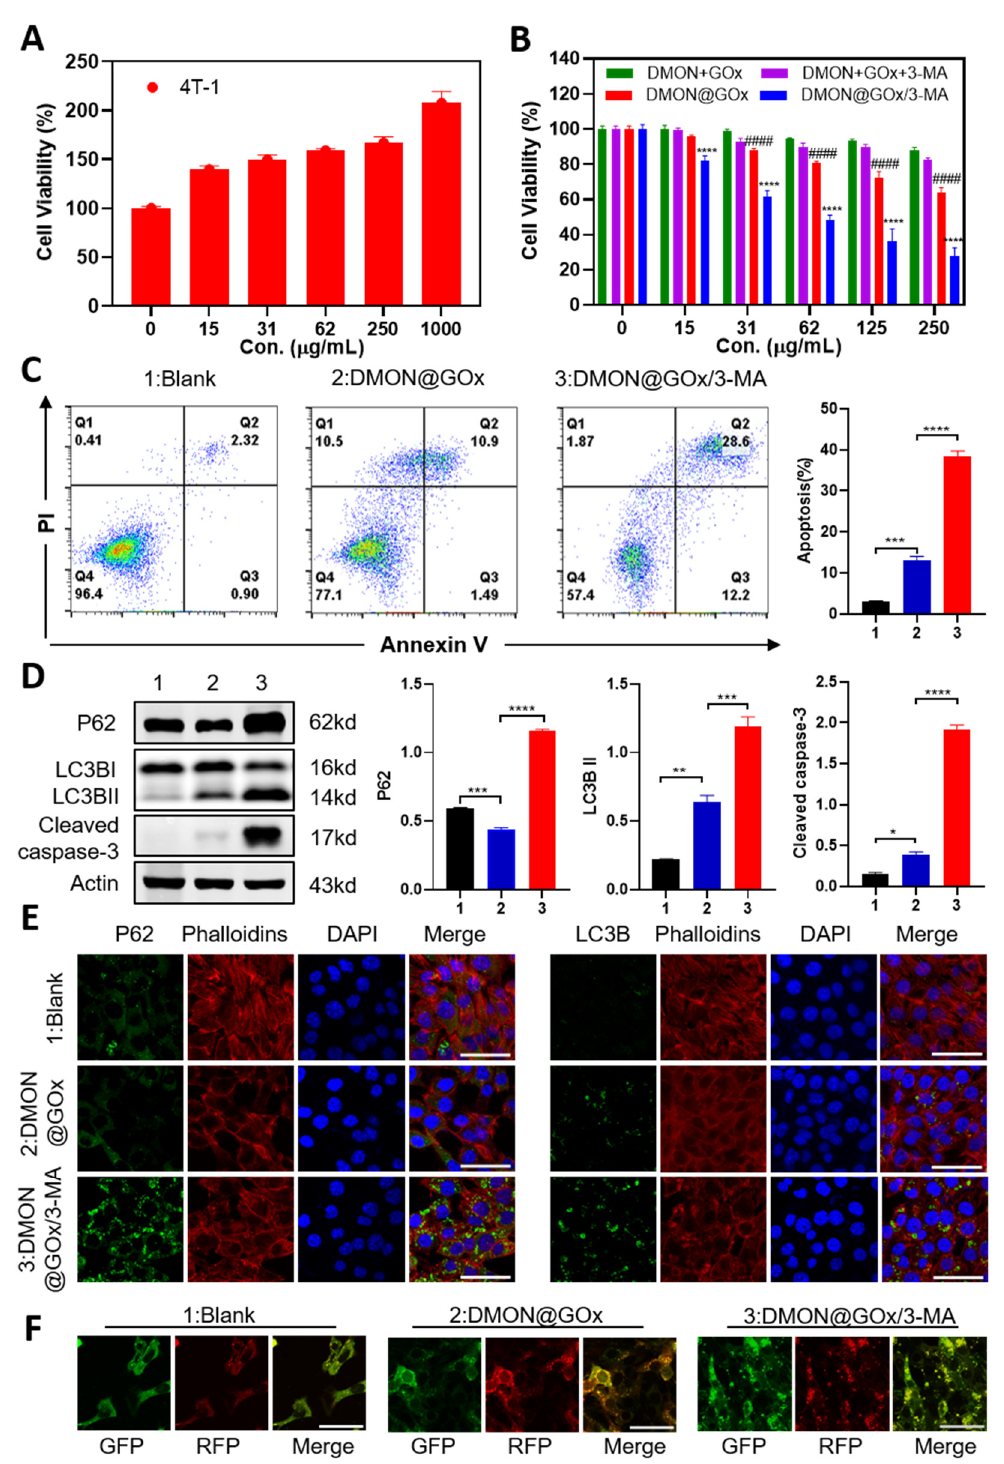
Figure 3. In vitro bioactivity of DMON@GOx/3-MA. ( A ) Cell viability of 4T1 cells treated with different concentrations of glucose for 24 h. ( B ) Cell viability of 4T1 cells treated with different concentrations of DMON@GOx, DMON@GOx/3-MA, DMON + GOx, and DMON + GOx + 3-MA. (* comparision between DMON@GOx and DMON@GOx/3-MA, # comparision between DMON@GOx and DMON + GOx). ( C ) Cell apoptosis analysis detected by PI and AnnexinV in 4T1 cells treated with 125 μ g/mL DMON@GOx and DMON@GOx/3-MA for 24 h. ( D ) Western blot and the grey level analysis of 4T1 cells treated as ( C ). ( E ) Immunofluorescence of P62 and LC3B of 4T1 cells treated as ( C ). ( F ) Immunofluorescence of tfLC3 puncta of 4T1 cells treated as ( C ). Scale bar: 50 μ m. * p < 0.1, ** p < 0.01,*** p < 0.001, **** p < 0.0001, #### p < 0.0001, p value was analysed by one-way ANOVA. Data are the means ± s.d.